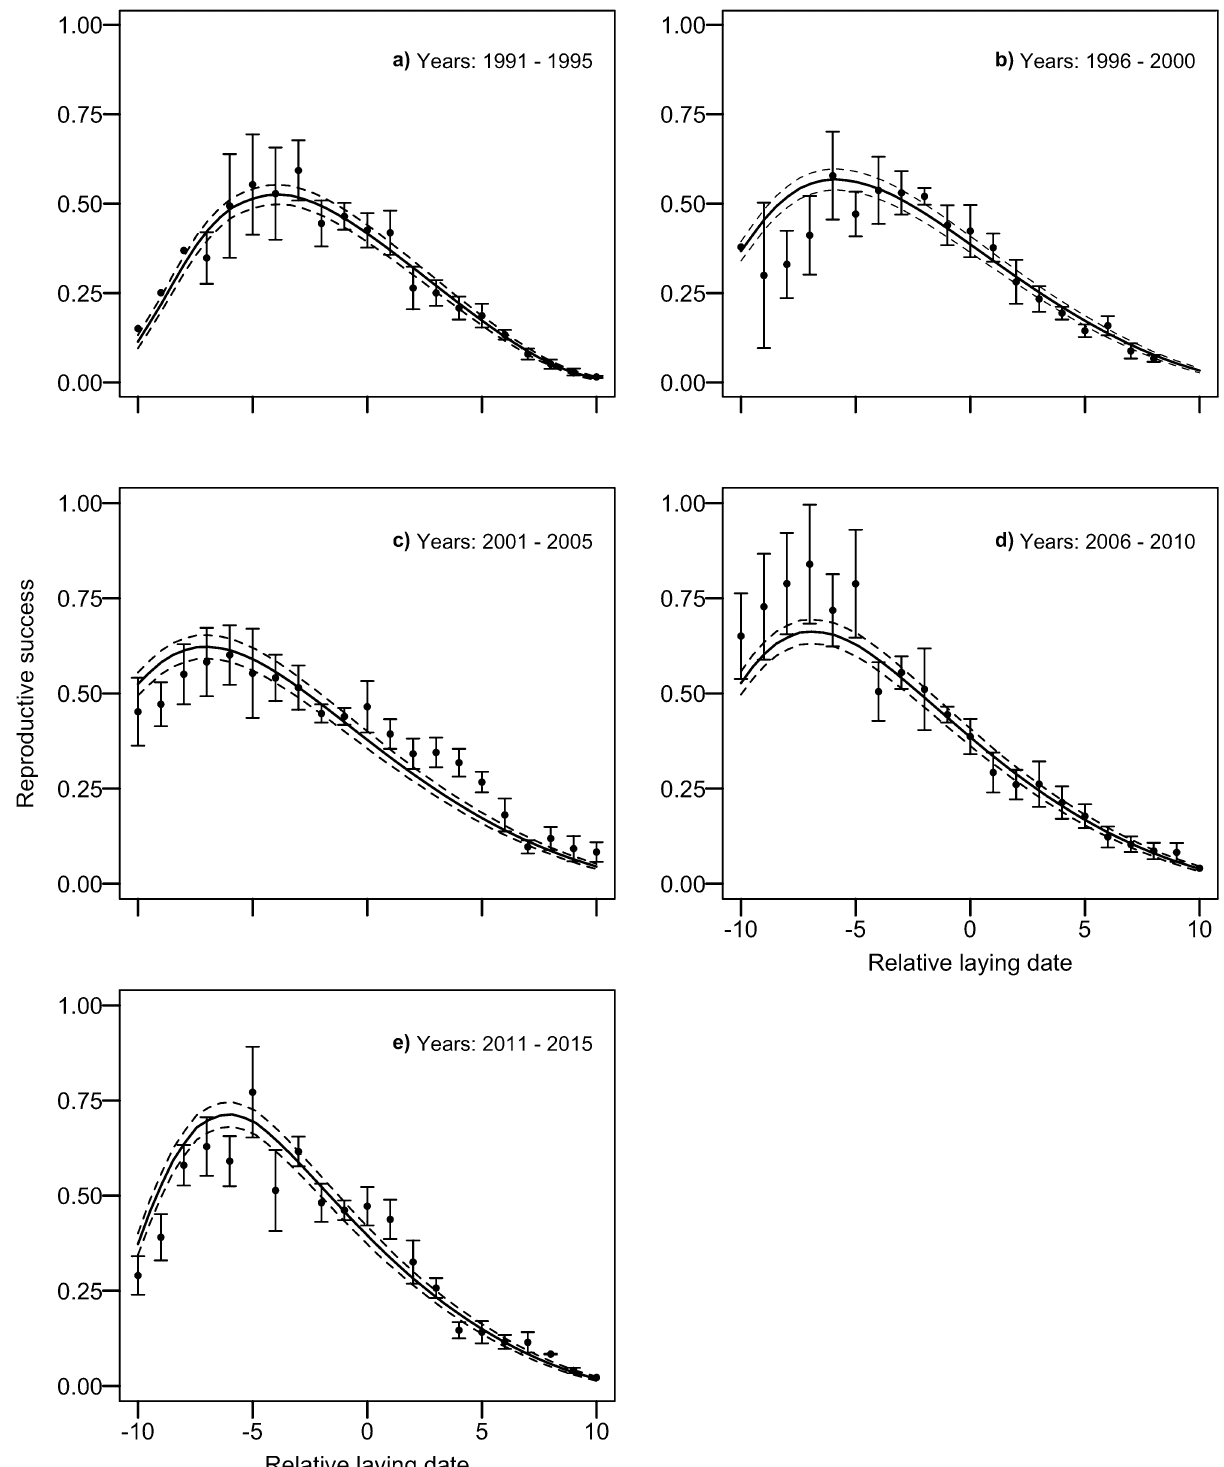
Figure 2. Observed reproductive success (black dots) in relation to relative laying date and predicted reproductive success (black line; black dotted lines represent the 95% CI) of greater snow geese derived from an analysis relating each reproductive component to laying date and study year (Table S1). Each data point is the mean over a 5-year period and the relationship is for the median year of the 5-year period. Error bars represent standard